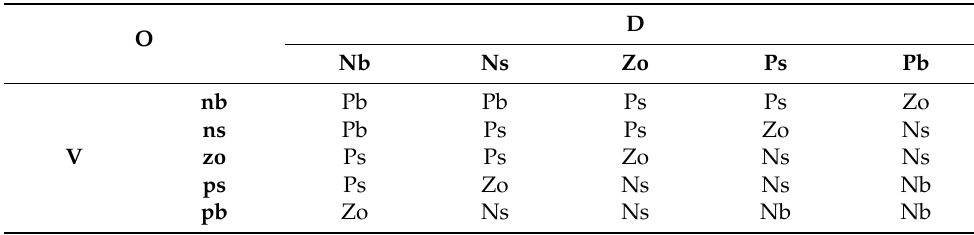
Table 1. Fuzzy guidance rule